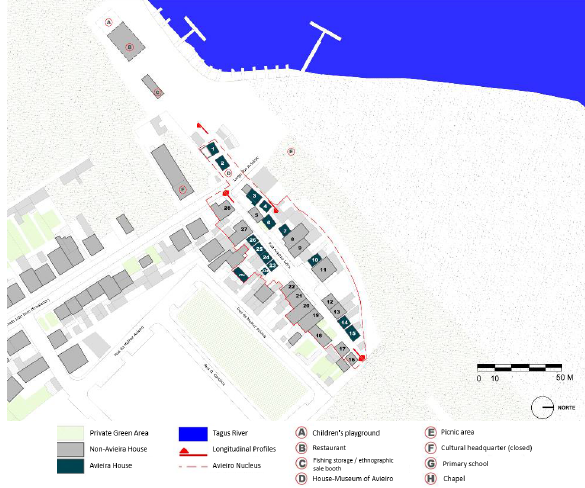
Figure 4: Escaroupim: characterization plan of the avieiro nucleus.